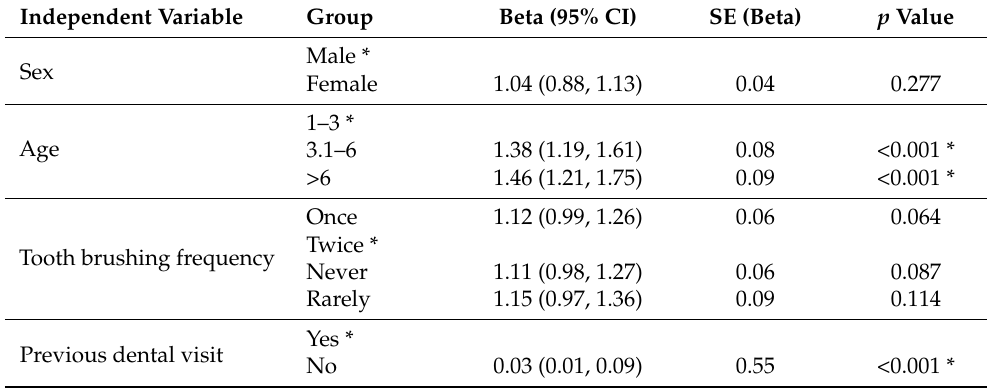
Table 6. The relationship between dmft scores and independent variables was